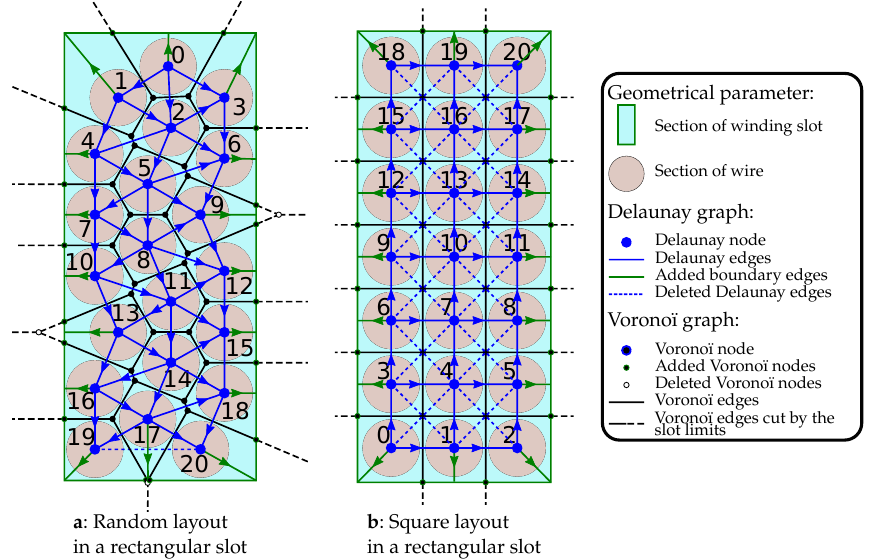
Figure 3. The equivalent thermal circuit for a 2D view of a rectangular slot with a random layout ( a ) and a square layout ( b